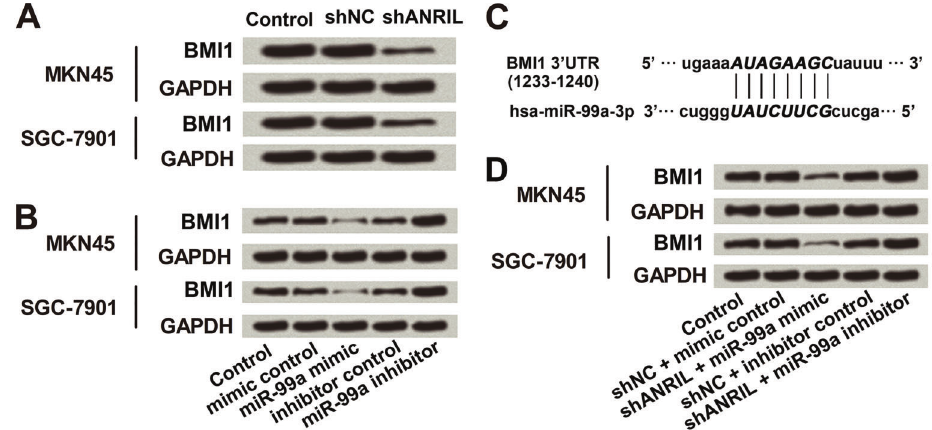
Figure 5. Knockdown of antisense non-coding RNA in the INK4 locus (ANRIL) inhibited the expression of BMI1 via miR-99a up-regulation. Protein expressions of BMI1 were measured by western blotting. A , ANRIL silence down-regulated BMI1 expression. B , Expression of BMI1 was negatively correlated with miR-99a expression. C , Putative binding sequence between miR-99a-3p and BMI1 3 0 UTR using TargetScan software. D , Down-regulation of BMI1, induced by ANRIL knockdown, was reversed by miR-99a inhibi- tion. shANRIL: pENTR TM /U6 vector carrying small hairpin RNA targeting ANRIL; shNC: pENTR TM /U6 vector carrying a non-targeting sequence; miR-99a: microRNA-99a; BMI1: B-lymphoma Mo-MLV insertion region 1; 3 0 UTR: 3 0 -untranslated region. Figure 6E and F, the expression of Notch1 was increased after overexpression of BMI1 and decreased in BMI1- silenced cells. The same expression trends were shown in phosphorylated mTOR and p70S6K in both MKN-45 and SGC-7901 cells. Accordingly, we speculated that over- expression of BMI1 could activate the Notch and mTOR signaling pathways.